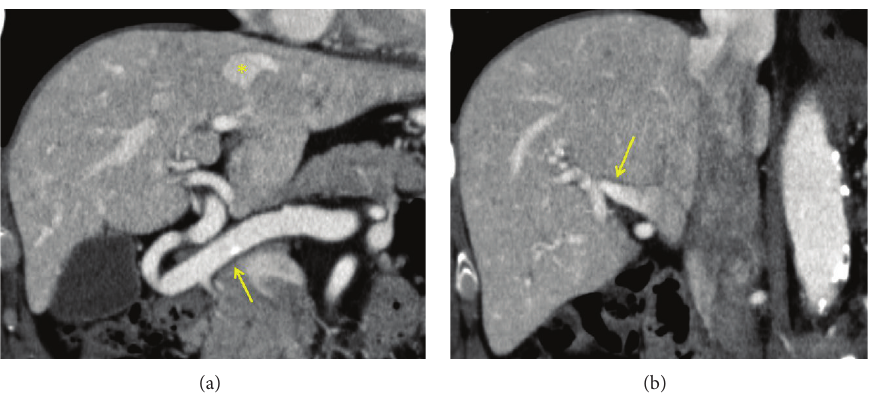
Figure 2: The arterial phase of dynamic contrast-enhanced CT scan: (a) significantly dilated extrahepatic artery (arrow), early enhancement of the hepatic veins (∗) , (b) early enhancement of the right branch of the portal vein (arrow).